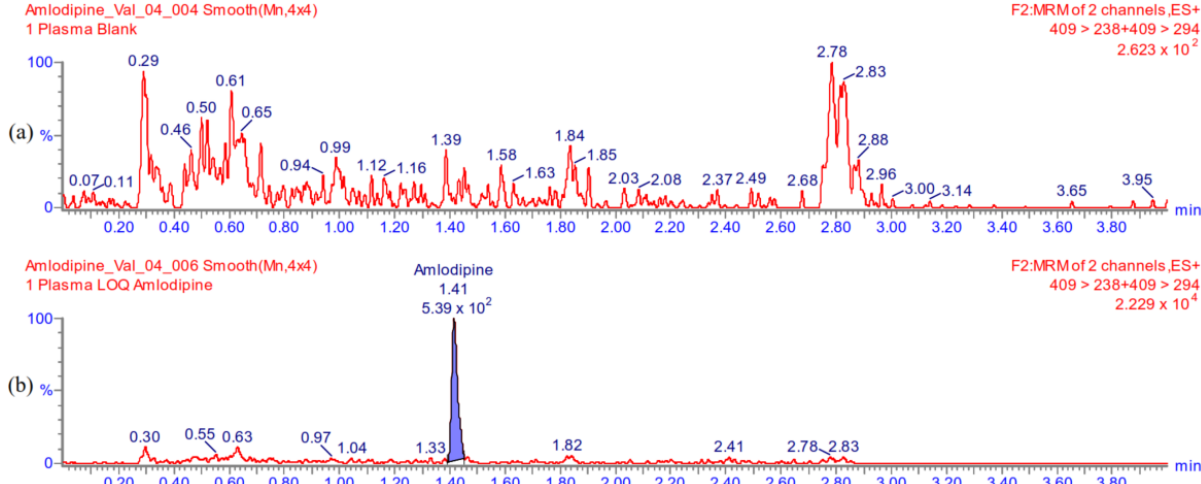
Figure A1. AML MRM chromatograms of human blood plasma source 1. ( a ) Blank plasma sample. ( b ) Plasma spiked with AML at 1.0 ng/mL.